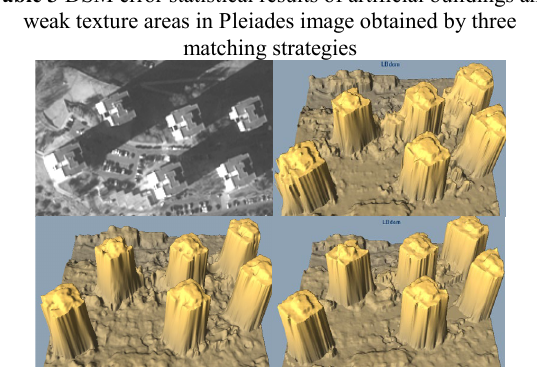
Figure 10 Comparison of DSM obtained by three methods in occlusion area (the upper left is the reference image, and the upper right, lower left and lower right correspond to methods ① , ② and ③ respectively)